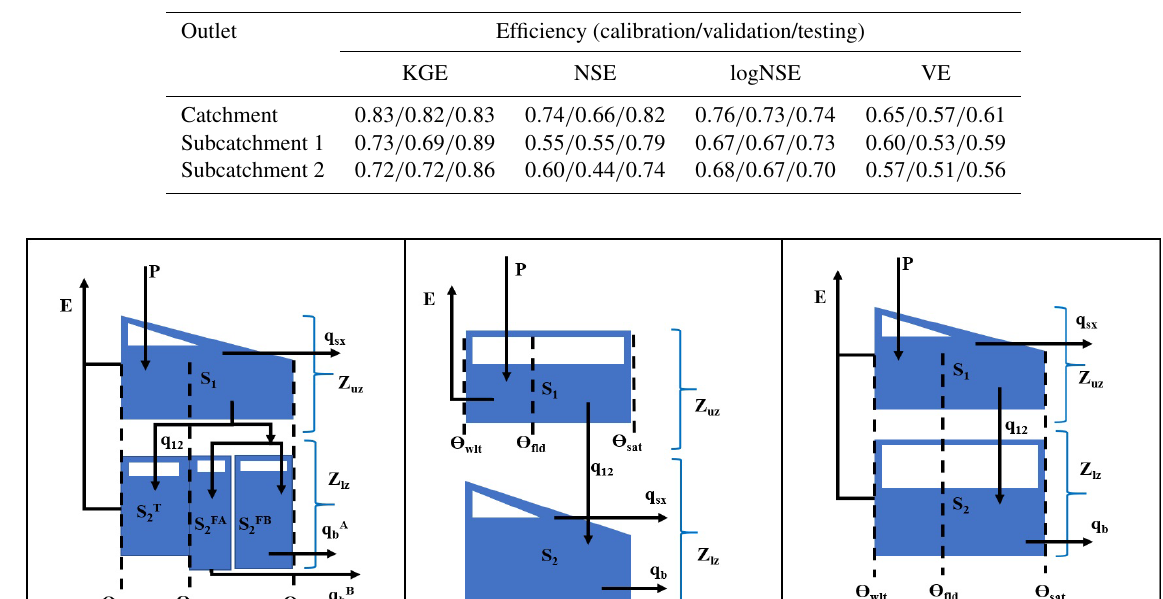
– tension 2 and q B – baseflow from the primary and b b